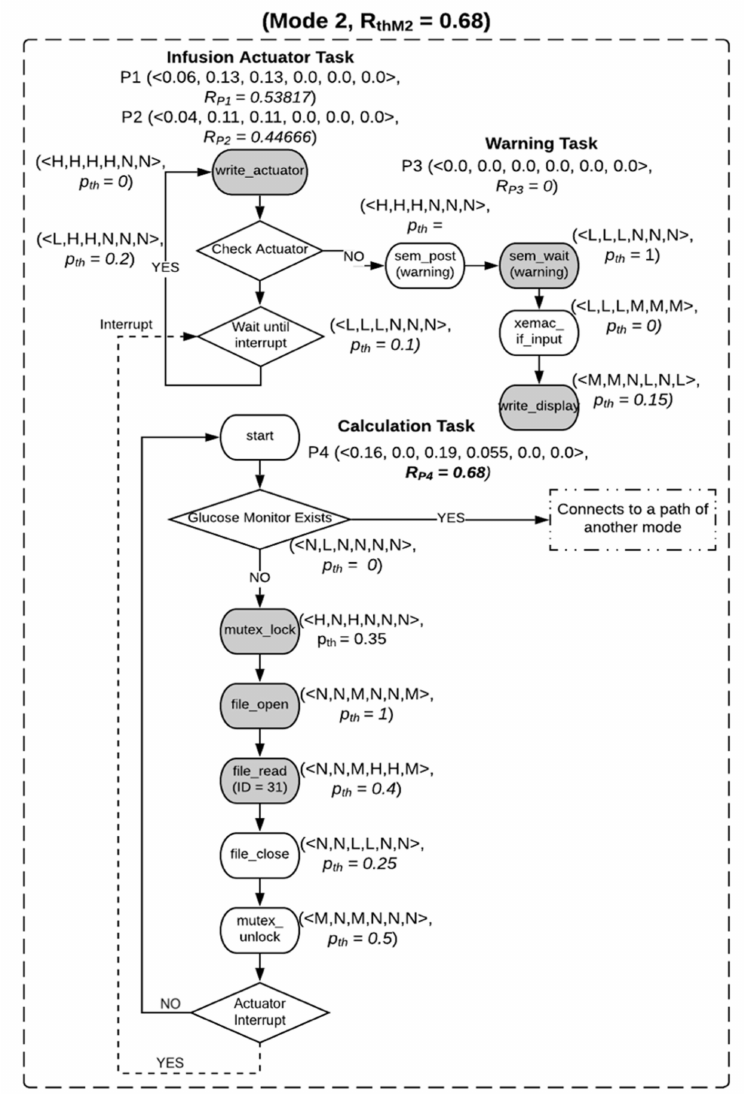
Figure 8. Illustration of the static risk evaluation for the insulin pump HCFR